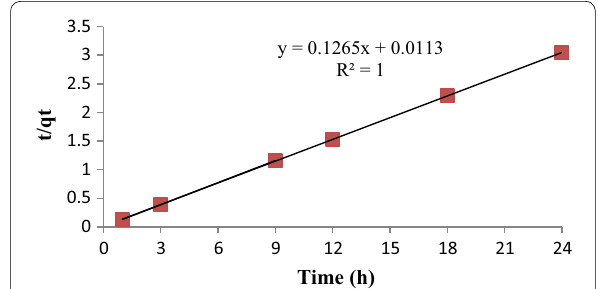
Fig. 6 Pseudo- second order kinetic model for bisacodyl adsorption by mesoporous silica, the results were well fitted (R 2 the well agreed with the Pseudo-second order kinetic